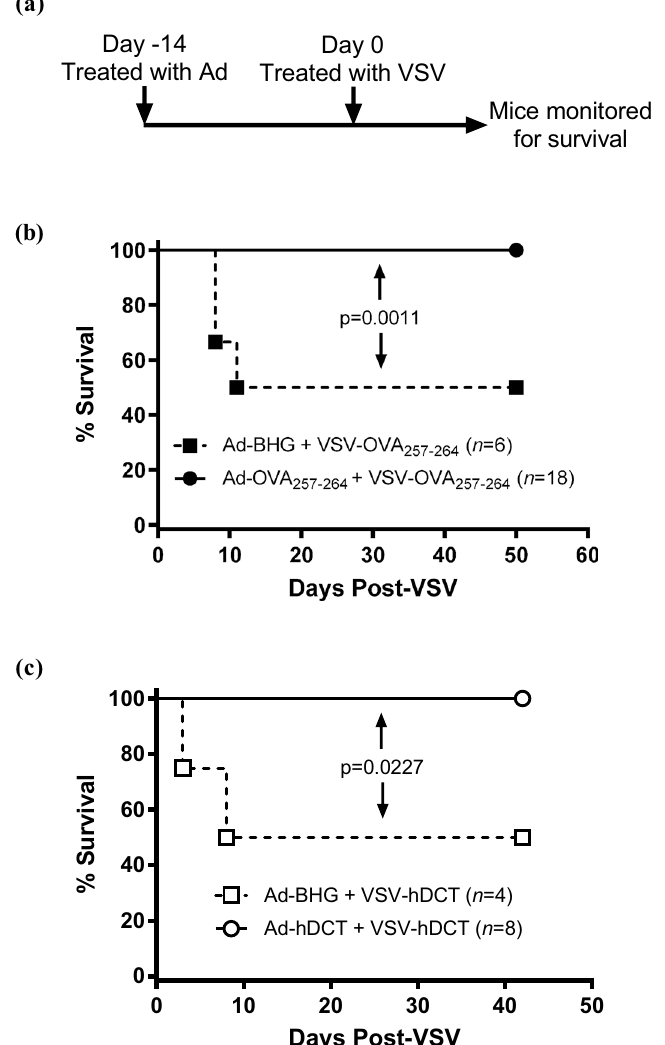
Figure 1. Inducing a primary immune response against an oncolytic virus-encoded transgene made the virus safer. (a) To assess the impact of primary vaccination on the safety of an oncolytic virus, when administered as a booster vaccine, tumor-free mice received intramuscular injections of 1 × 10 8 IU of an E1/E3-deleted replication-deficient human serotype 5 adenovirus (Ad) with a transgene encoding an antigen on day −14. This was followed fourteen days later (on study day 0) by intravenous administration of 3 × 10 9 pfu of vesicular stomatitis virus (VSV) encoding the same antigen. Survival was measured in days following treatment with VSV. Controls received an Ad that lacked a transgene but the same VSV-vectored vaccine as the test mice. Kaplan– Meier survival plots were calculated for (b) C57BL/6 or (c) Balb/c mice that were primed with Ad expressing (b) the immunodominant epitope from ovalbumin (OVA 257-264 ) or (c) full-length human dopachrome tautomerase (hDCT) followed fourteen days later by intravenous boosting with VSV encoding the same antigen. Controls received adenoviruses that lacked a transgene (Ad-BHG). Mice were monitored and euthanized if they showed signs of reaching endpoint, which was always the onset of hind-limb weakness or paralysis. The data were analyzed using the Mantel-Cox log-rank method. Out of consideration for animal welfare, data shown in (b,c) were derived from single